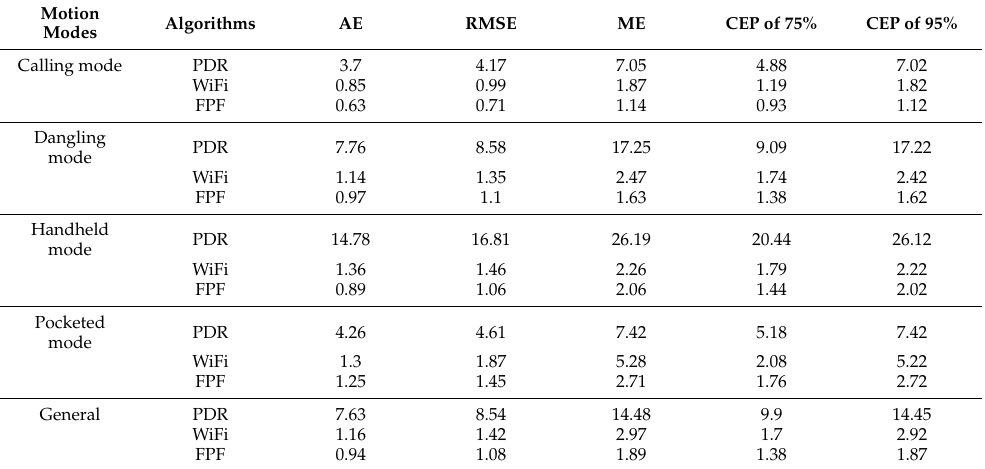
Table 2. Position errors for PDR, WiFi and FPF (m).